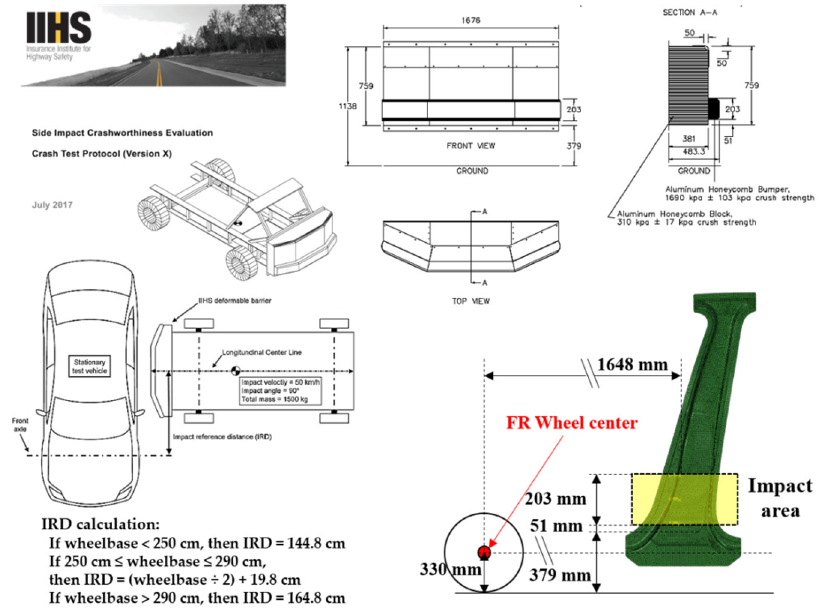
Figure 13. Side impact standard of Insurance Institute for Highway Safety (IIHS) [20].